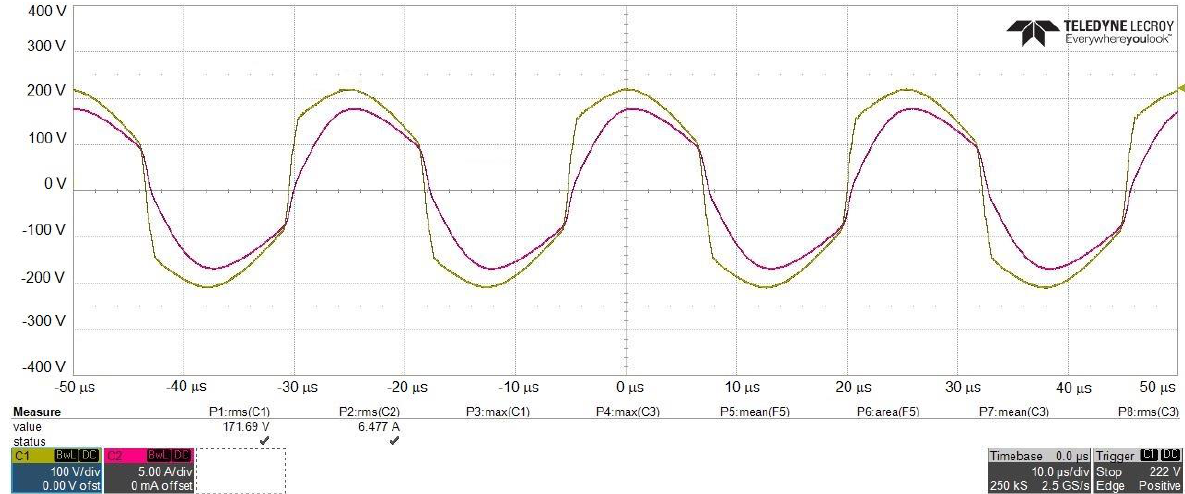
Figure 28. Receiver coil voltage (C1, green) and current (C2, purple) at 75 kHz.